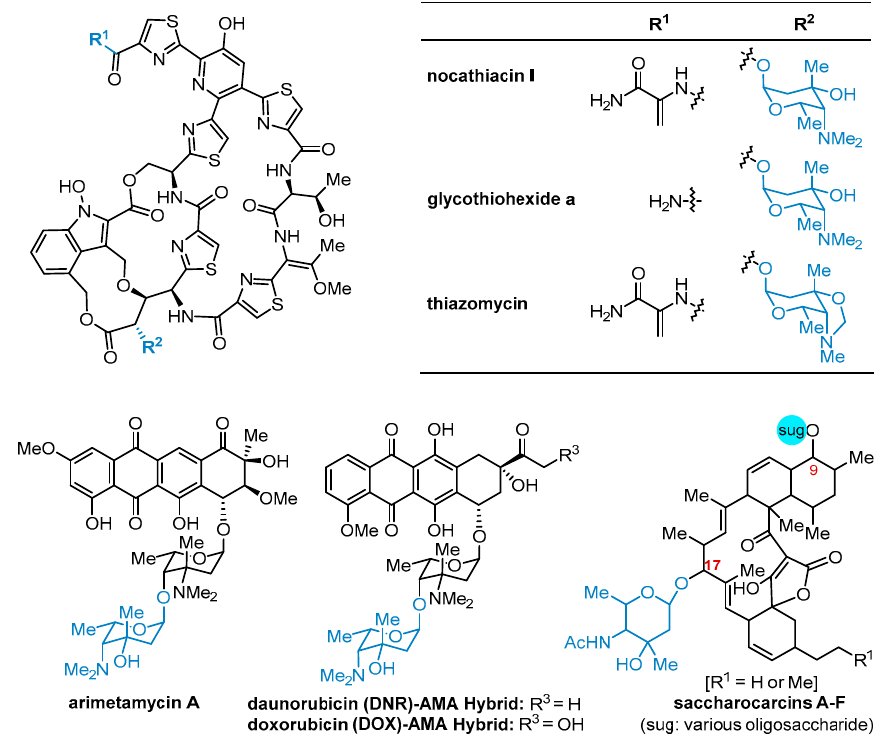
Figure 3. Antibiotics bearing 2,6-dideoxy-4-aminoglycoside (blue).